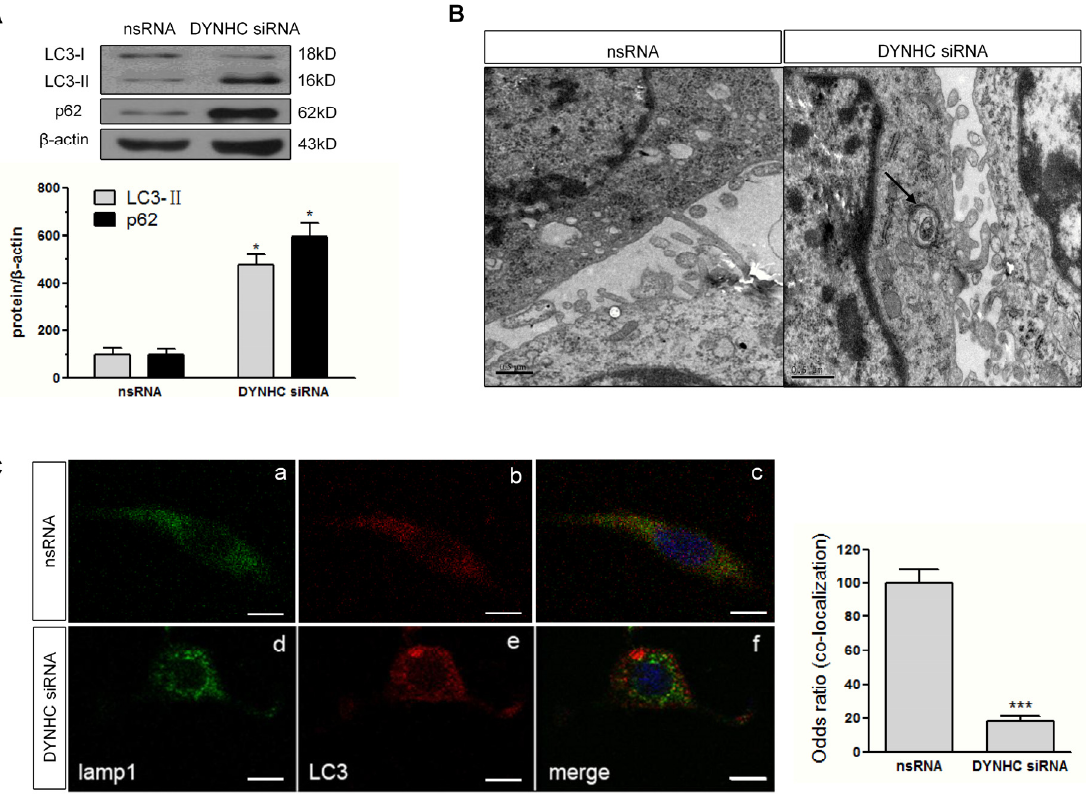
Figure 4. Autophagic flux is impaired in dynein-silencing PC12 cells. ( A ) LC3-II and p62 levels were determined by western blotting at 48 h following dynein knockdown in PC12 cells. Graphs represent the quantification of protein expression relative to actin from three independent blots; ( B ) Electron microscopy examination of autophagosome formation at 48 h after dynein knockdown. Arrows indicate typical autophagosomes in PC12 cells with dynein knockdown. Photos were taken at 20,000× magni fi cation. Scale bar: 0.5 μ m; ( C ) Cells were stained for LC3 (red) and lamp-1 (green) in control ( a , b ) and dynein-RNAi group ( d , e ). c and f represents the co-localization of LC3 with lamp-1 in control ( c ) and dynein-RNAi group ( f ), respectively. Nuclei were stained with hoescht 33258 (blue). Photos were taken at 630× magni fi cation. Scale bar: 10 μ m. The number of autophagosome-lysosome fusion corpuscles (odds ratio) are shown in the panel. * p < 0.05 versus its corresponding controls; *** p < 0.001 versus